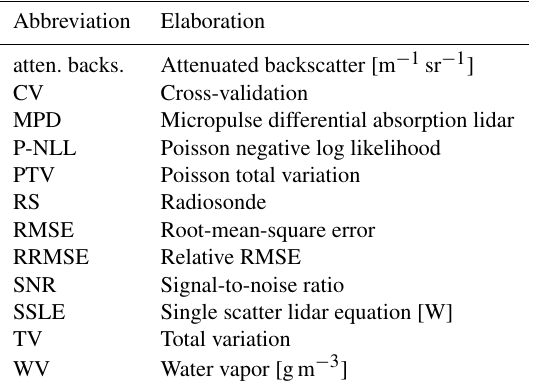
Table 2. Commonly used